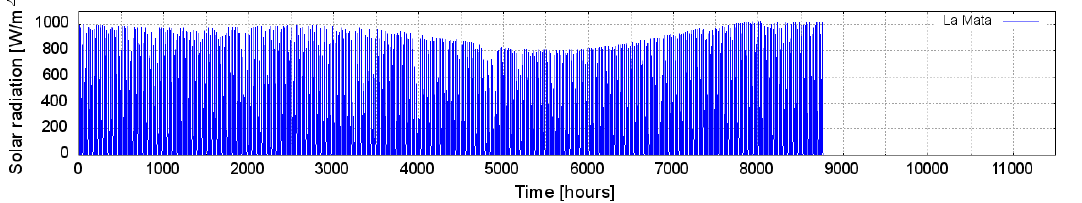
Figure 5. Solar radiation time series from La Mata, Oaxaca (hourly averages).